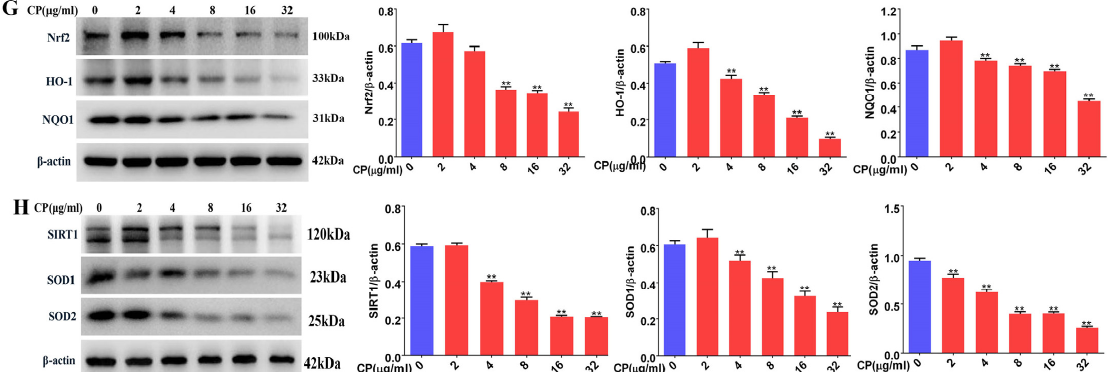
Figure 8. Cisplatin increased apoptosis and downregulated the MT1, MT2, and SIRT1/Nrf2 signaling pathways in Leydig cells. ( A ) CCK8 was used to determine the relative cell survival of Leydig cells after treatment with various doses of cisplatin for 24 h. ( B ) CCK8 was used to determine the relative cell viability of Leydig cells treated with 8 μ g/mL of cisplatin for different lengths of time. ( C ) Images of Leydig cells treated with various doses of cisplatin for 24 h. ( D ) Apoptosis was observed by flow cytometry analysis in Leydig cells treated with various doses of cisplatin for 24 h. ( E ) Apoptotic cell percentages are shown. ( F ) Determination of MT1 and MT2 protein levels was performed by Western blotting in Leydig cells treated with various doses of cisplatin for 24 h. The blots were quantified using Image J software. ( G ) Determination of the Nrf2, HO-1, and NQO1 protein levels was performed by Western blotting in Leydig cells treated with various doses of cisplatin for 24 h. The blots were quantified using Image J software. ( H ) Determination of SIRT1, SOD1, and SOD2 protein levels was performed by Western blotting in Leydig cells treated with various doses of cisplatin for 24 h. The blots were quantified using Image J software. CP, cisplatin. Data are presented as the mean ± SEM ( N = 4 per group). * p < 0.05 or ** p < 0.01 compared with